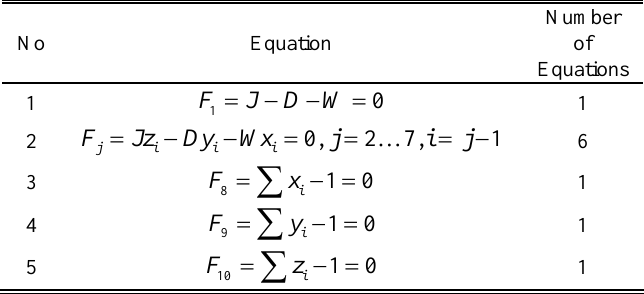
Table 3. Constraint equations of rectification